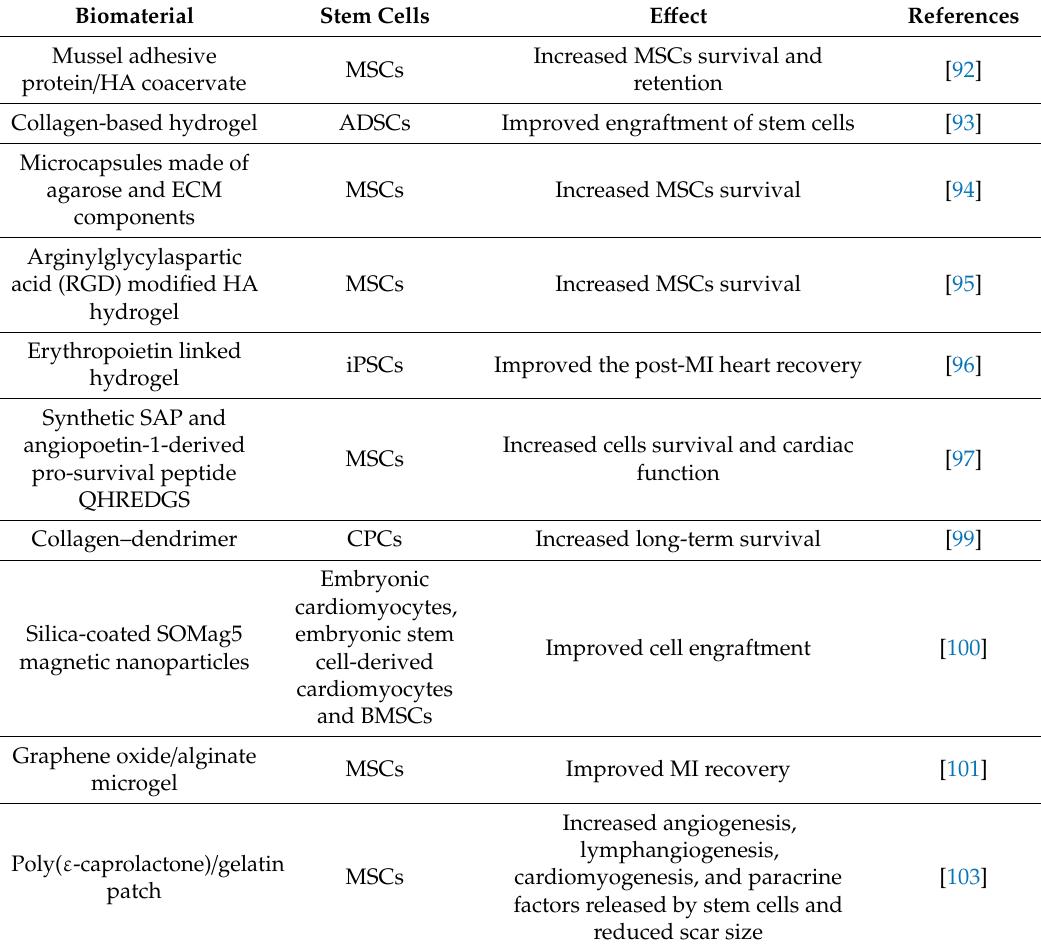
Table 2. Biomaterials loaded with stem cells for cardiac tissue regeneration. Biomaterial Stem Cells E ff